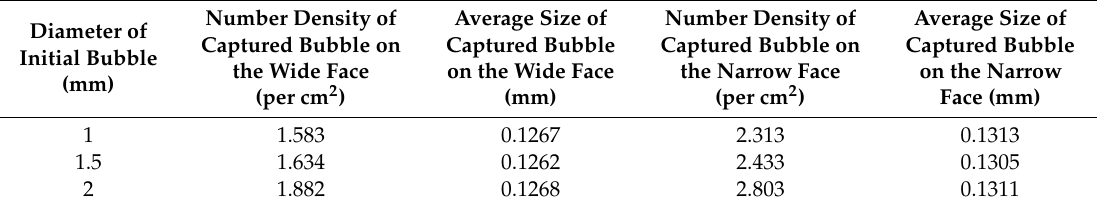
Table 6. Captured bubble distribution with di ff erent initial bubble sizes at the operation casting speed of 1.5 m / min and a gas flow rate of 4.1% gas volume fraction.